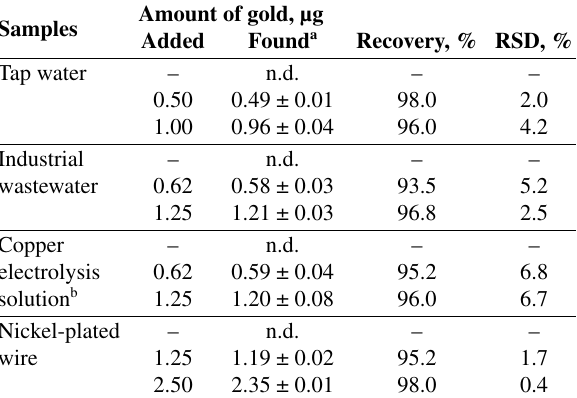
Table 7. Determination of gold in real samples(n:4)